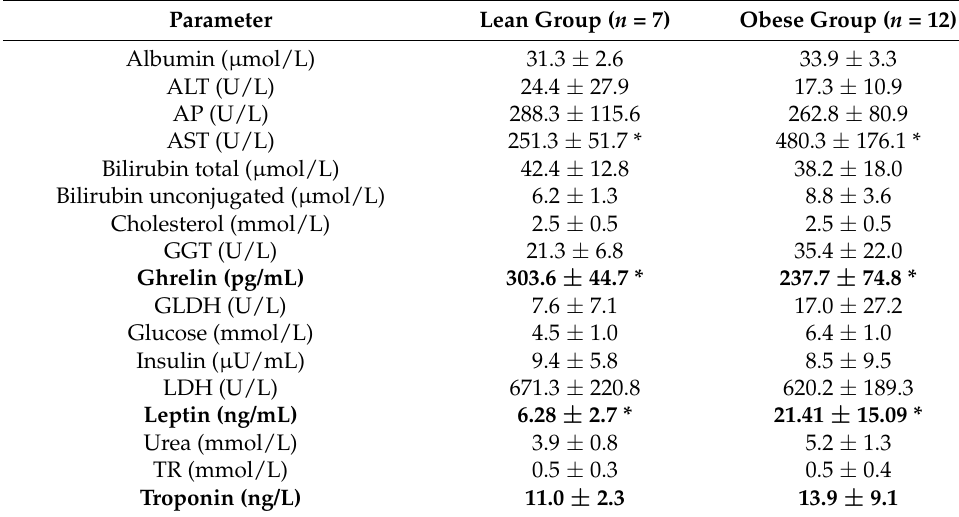
Table 2. Basic parameters of blood chemistry in examined and control group. Results are shown as average ± standard deviation. Statistically significant differences ( p < 0.05) are marked with an